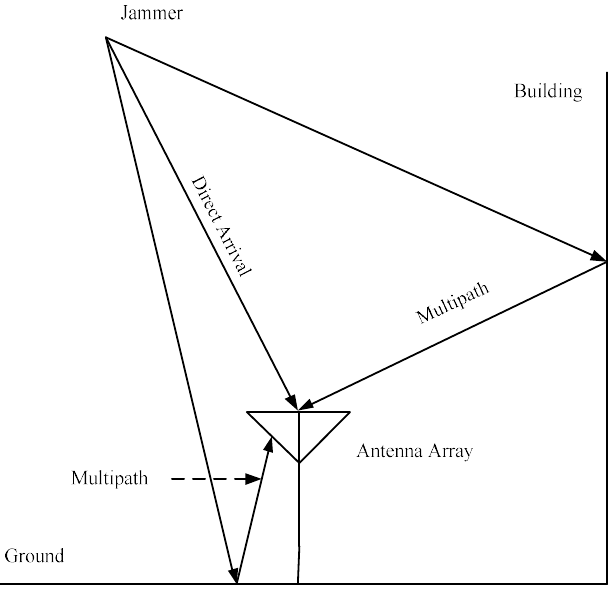
Figure 3. Antenna array structure.